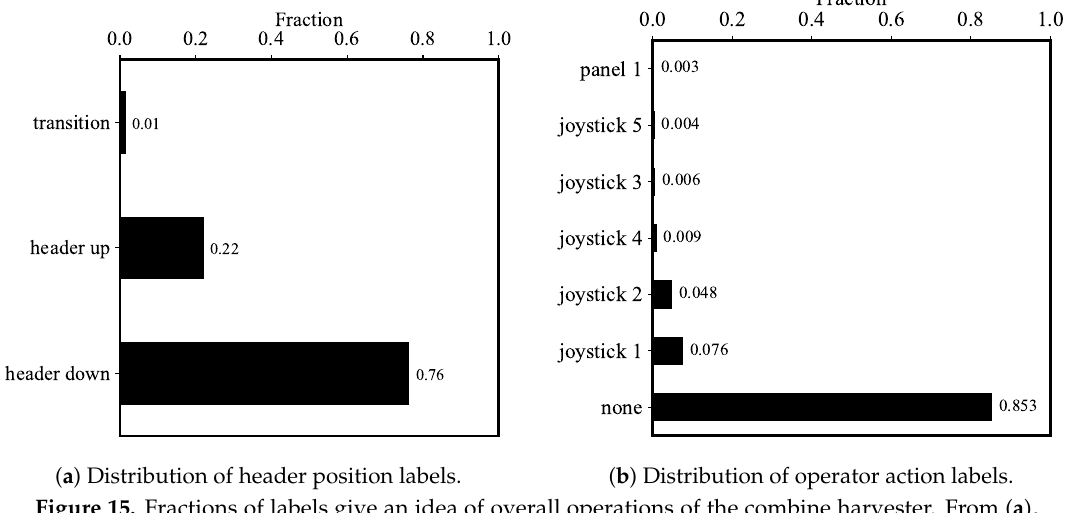
Figure 15. Fractions of labels give an idea of overall operations of the combine harvester. From ( a ), “header down” is the logical status for header position as the combine needs to lower the header to harvest. For ( b ), “joystick 1” and “joystick 2” has the second and third biggest fractions due to operator’s consistent adjustment of header reel height and header height when cutting